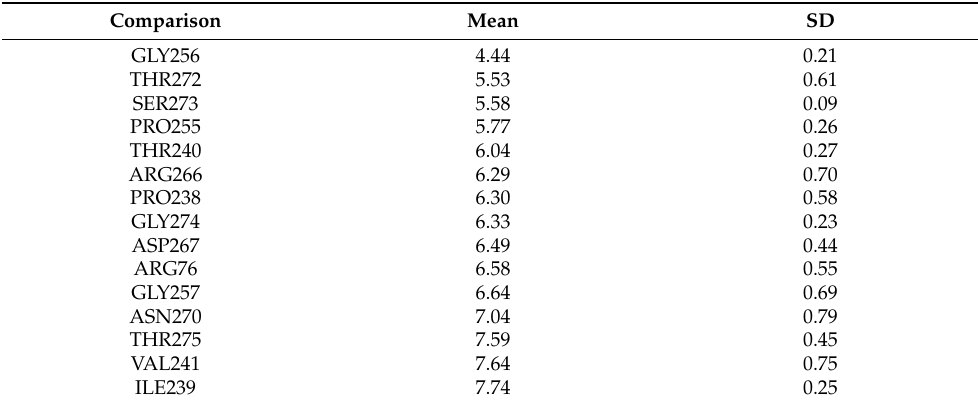
Table 6. Distances of the residues of PS2Aa1 relevant to interacting with APN.